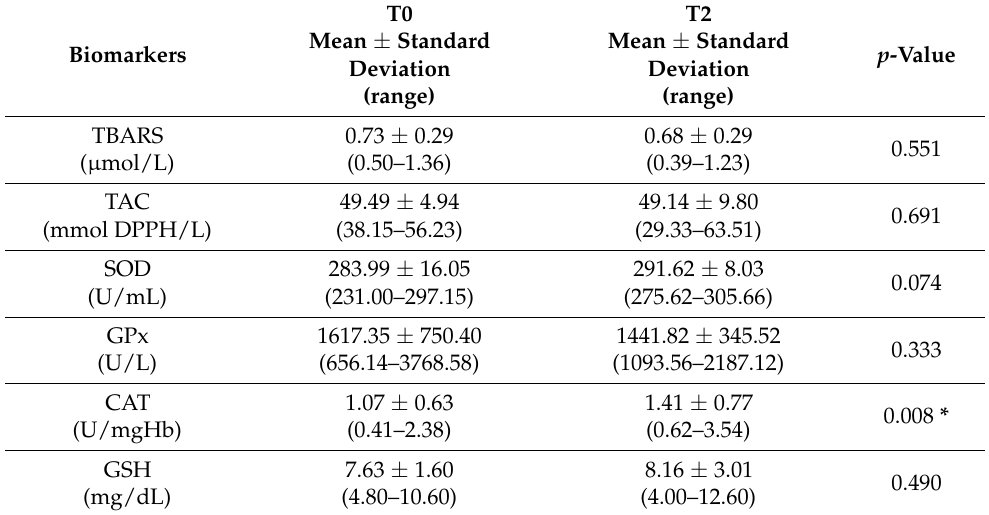
Table 2. Biochemical characteristics of the